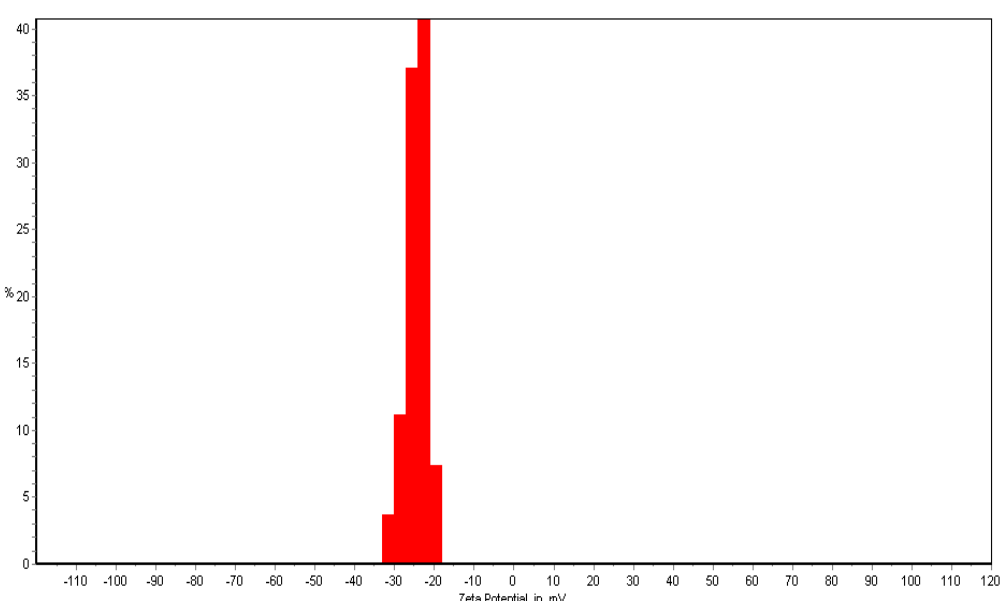
Figure 3. The zeta potential of the biosynthesized Ab